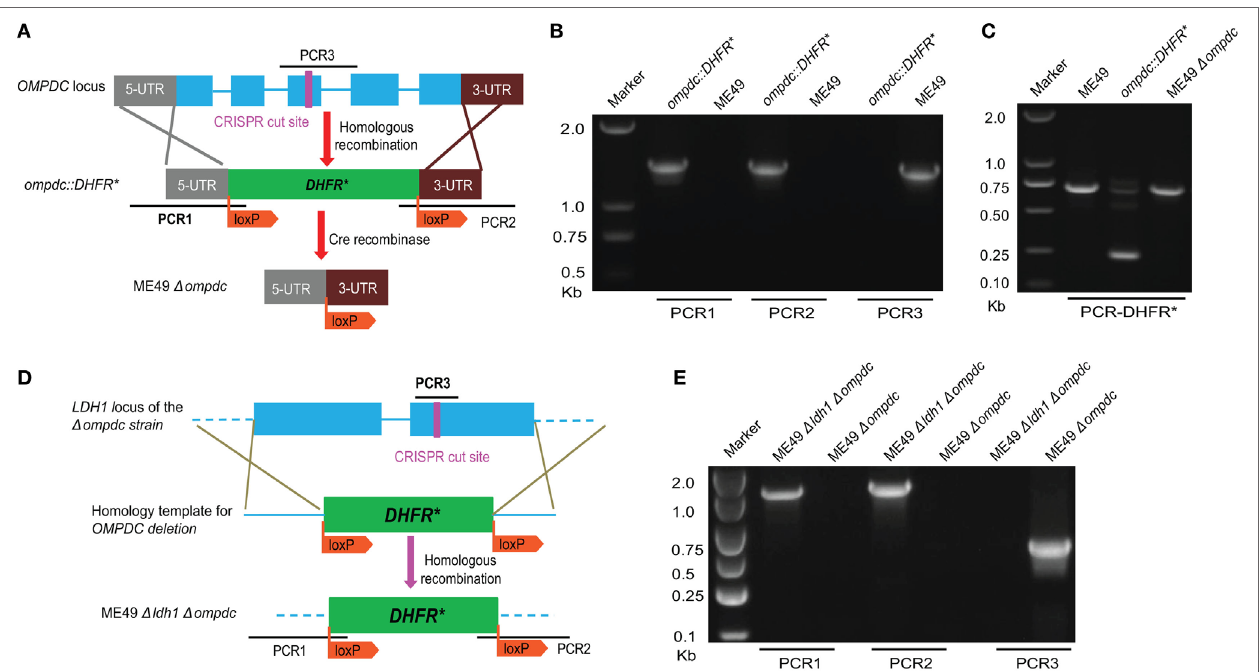
FigUre 9 | Generation of OMPDC deletion mutants. (a) Schematic illustration of OMPDC replacement by the selection marker DHFR* and subsequent removal of DHFR* by Cre recombinase. (B) Diagnostic PCR on an ompdc:DHFR* clone. PCR1 and PCR2 check the integration of DHFR* at the 5 ′ and 3 ′ end of OMPDC , respectively, whereas PCR3 examines the presence of OMPDC sequence. (c) Diagnostic PCR confirming the removal of DHFR* by Cre recombinase. This PCR generated a 700 bp product from the endogenous DHFR locus, and a 250 bp product from DHFR* due to the absence of introns. Absence of the 250 bp product in ompdc:DHFR* treated with Cre indicates removal of DHFR* . (D) Diagram illustrating the deletion of LDH1 in Δ ompdc to make the double mutant Δ ompdc ldh1:DHFR* , by CRISPR/Cas9-mediated homologous gene replacement. (e) Diagnostic PCR on a Δ ompdc ldh1:DHFR*